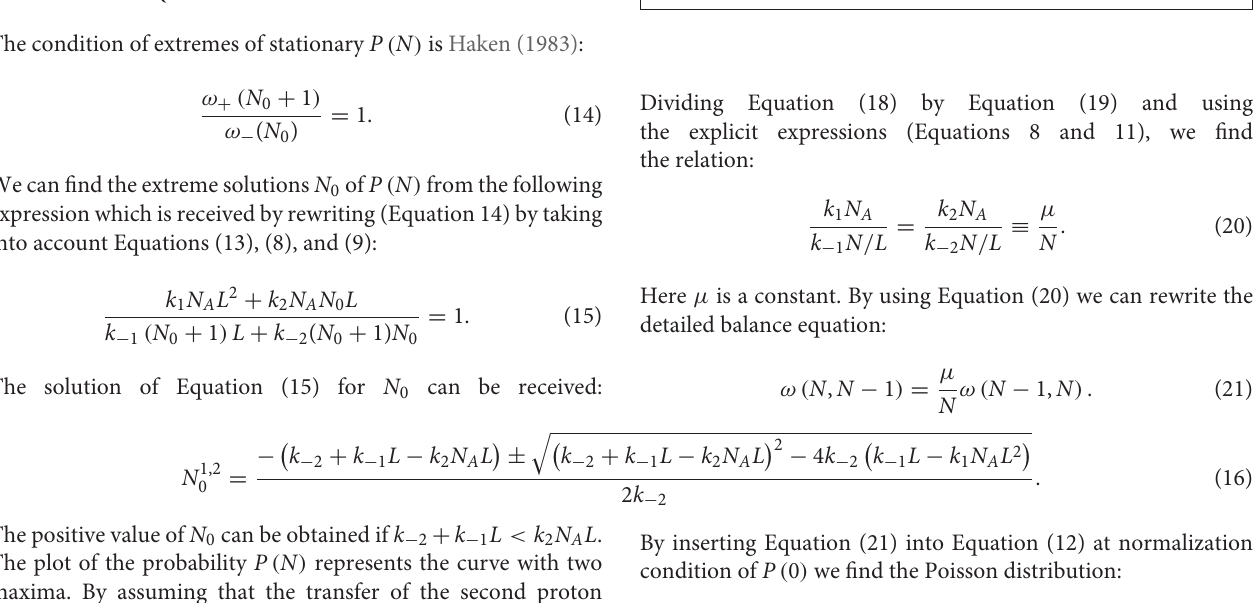
FIGURE 3 | Non-poissonian distribution function P(N) of spontaneous mutations in DNA by Löwdin’s mechanism.